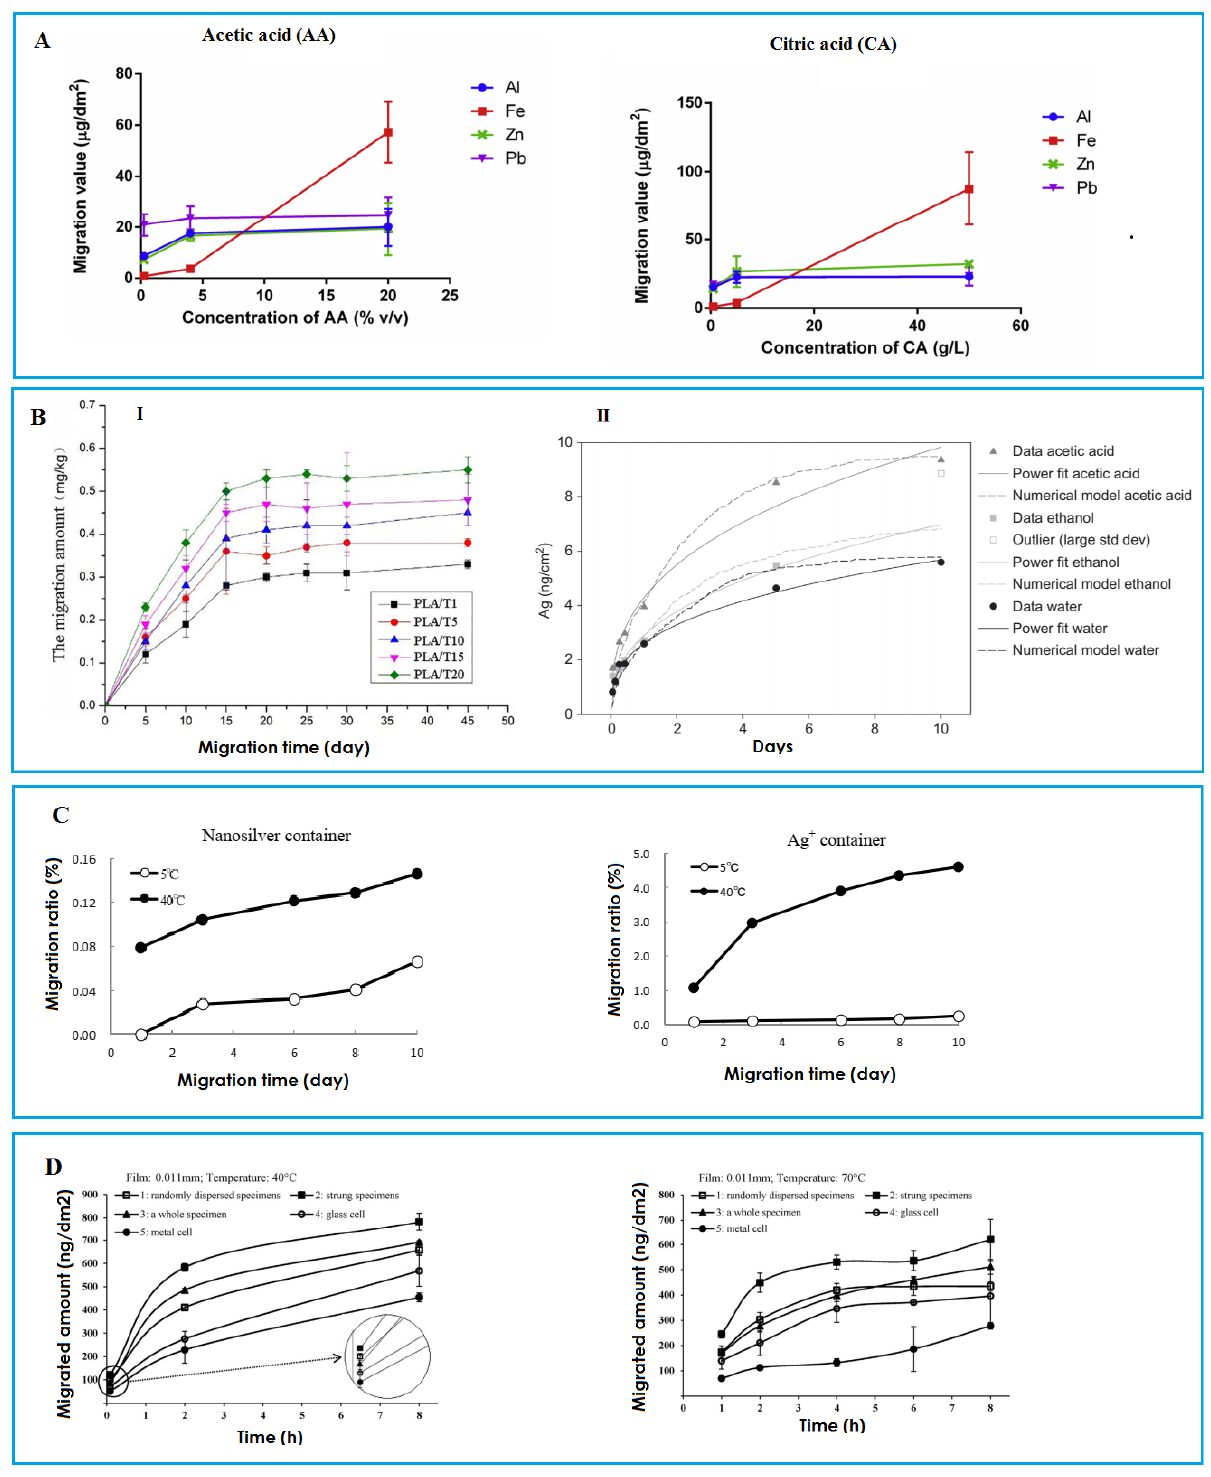
Figure 5. ( A ) Migration of metals (Al, Ba, Fe) into 0.25%, 4% and 20% acetic acid (AA) and citric acid (CA). Reprinted